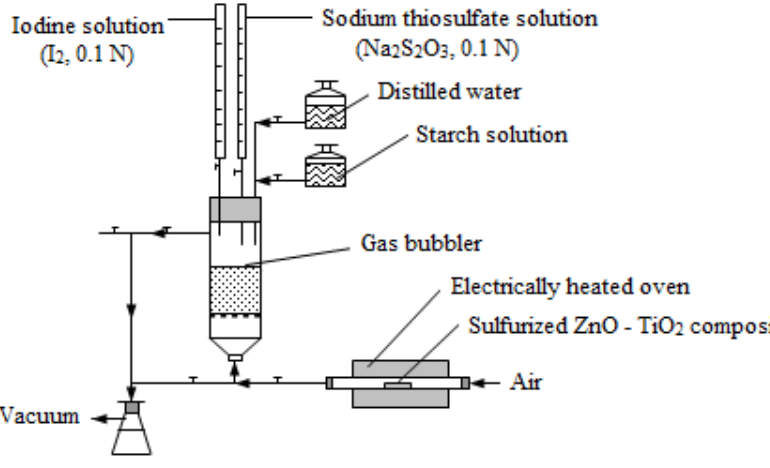
Figure 2. The sketch of the laboratory plant for sulfurized ZnO-TiO 2 composite regeneration.